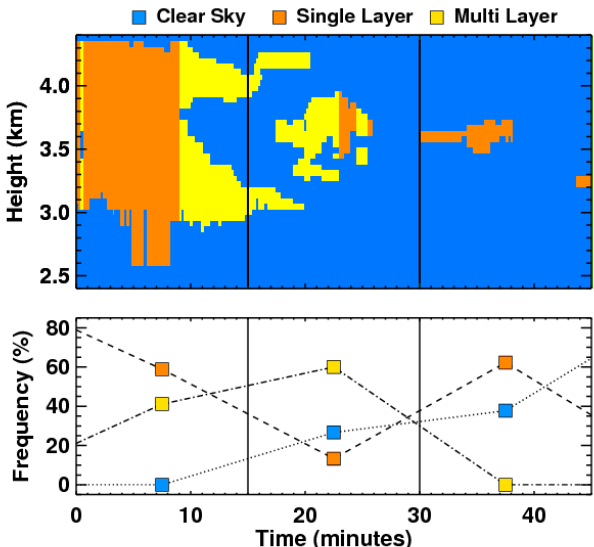
Fig. 5. An illustration of the classification of cloud layer struc- tures. It is zoom-in snapshot of the period of 15:00–15:45UTC of the example shown in Fig.